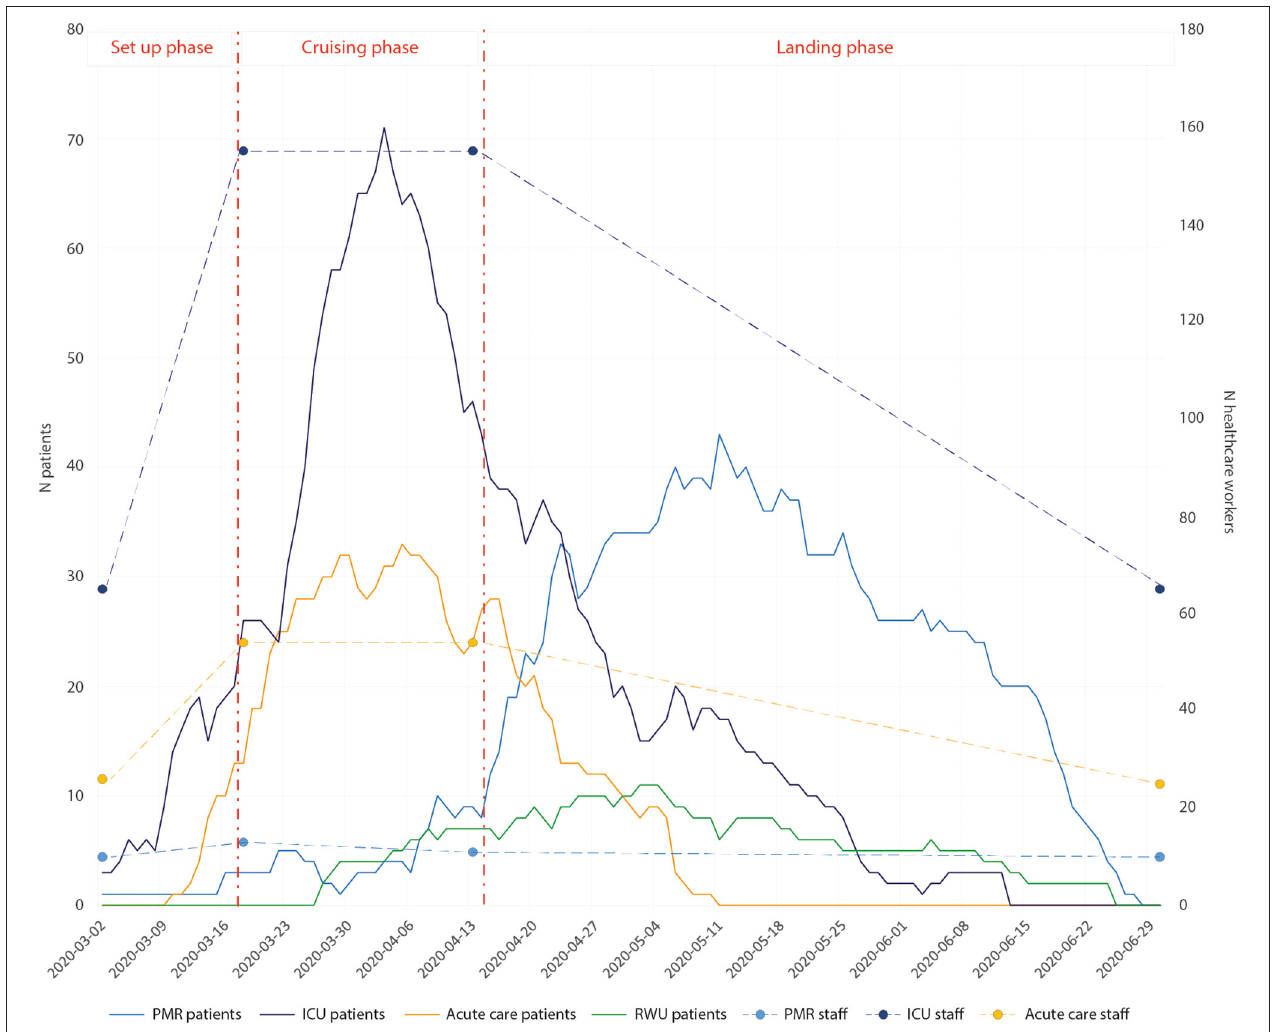
FIGURE 3 | Visualization of patient numbers by date and the three phases of the crisis. The healthcare staff in intensive care and acute care are informed at the start of each phase and a trend in staff numbers is reported for each phase. PMR, physical medicine and rehabilitation; ICU, intensive care unit; RWU, respiratory weaning unit.